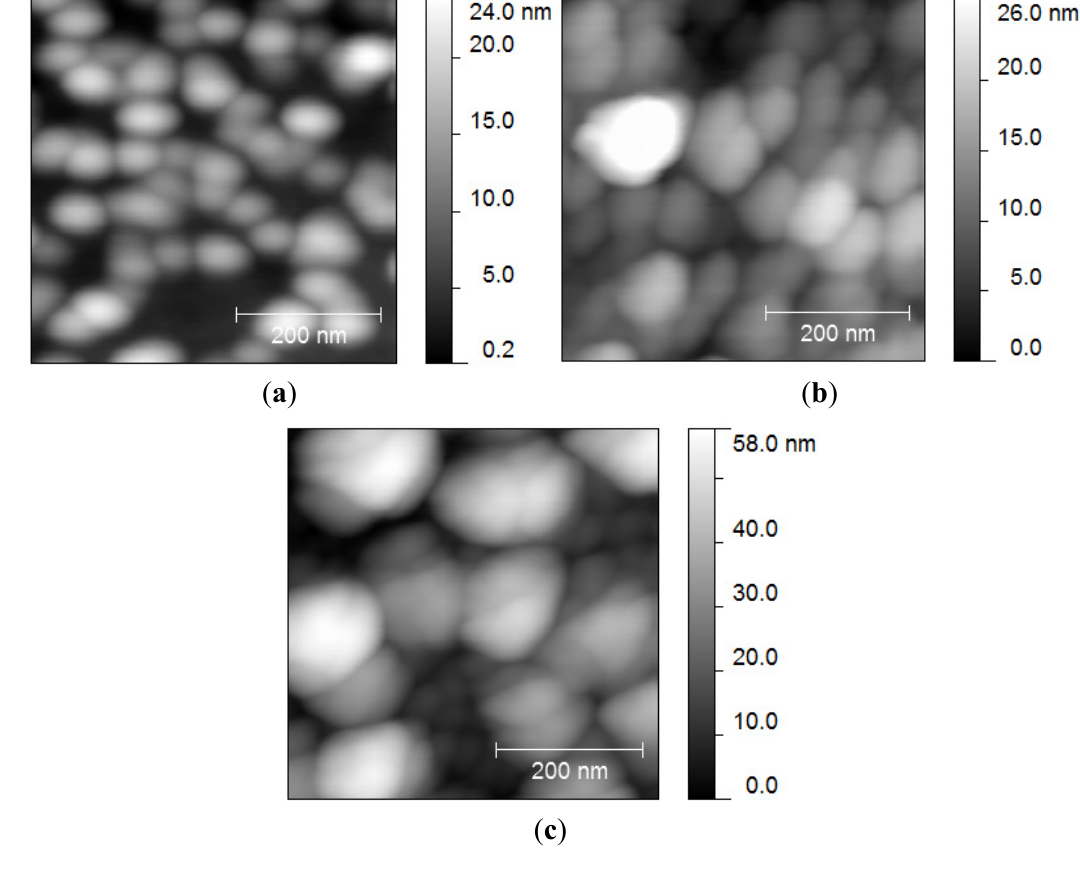
Figure 4. AFM images of: ( a ) as-grown thin films; ( b ) annealed films in oxygen and ( c ) annealed films in dry